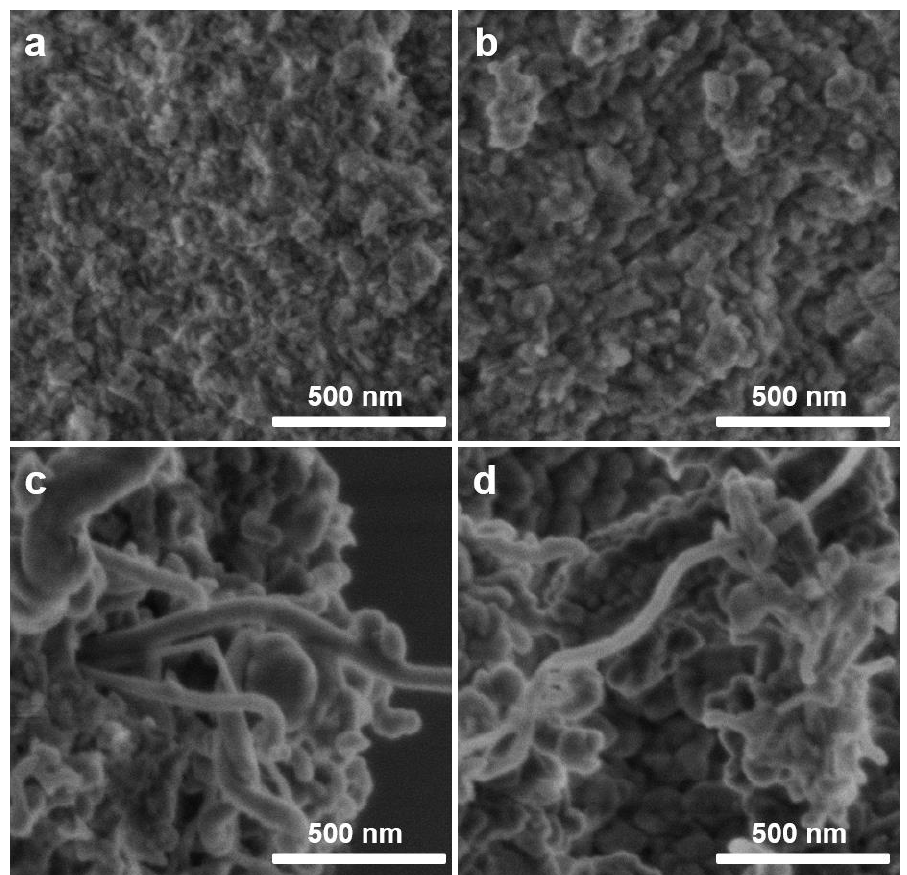
Figure 9. SEM images of the Ni x Mg 1-x O catalysts after the continuous CRM reactions at 700 ◦ C for 36 h. ( a ) Ni 0.03 Mg 0.97 O; ( b ) Ni 0.1 Mg 0.9 O; ( c ) Ni 0.2 Mg 0.8 O; (d) Ni 0.1 Mg 0.9